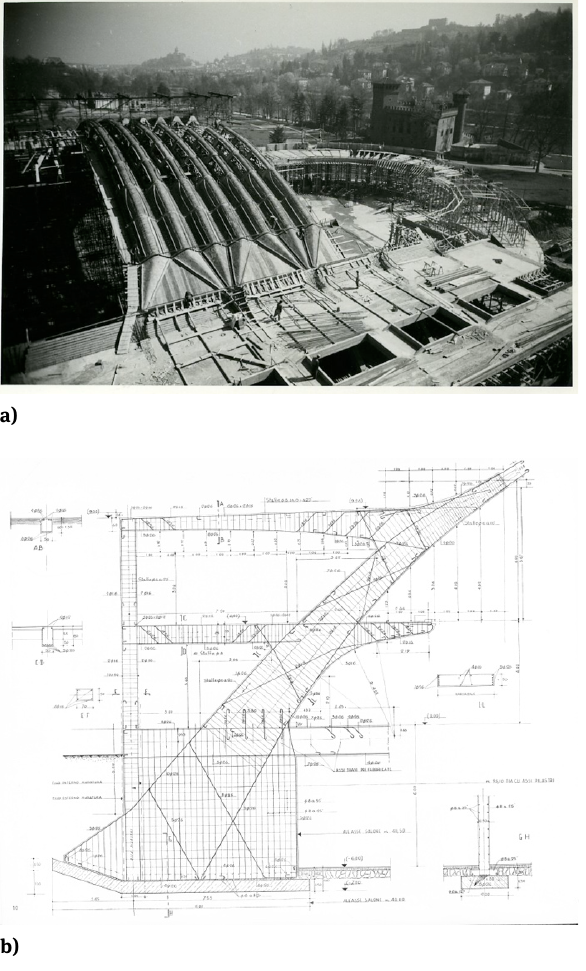
Figure 3: (a) Advancement of the construction site with the elevation of the first portion of the undulated vault (photos by Riccardo Mon- calvo). (b) Detail of the reinforcing of the pillars and the connections